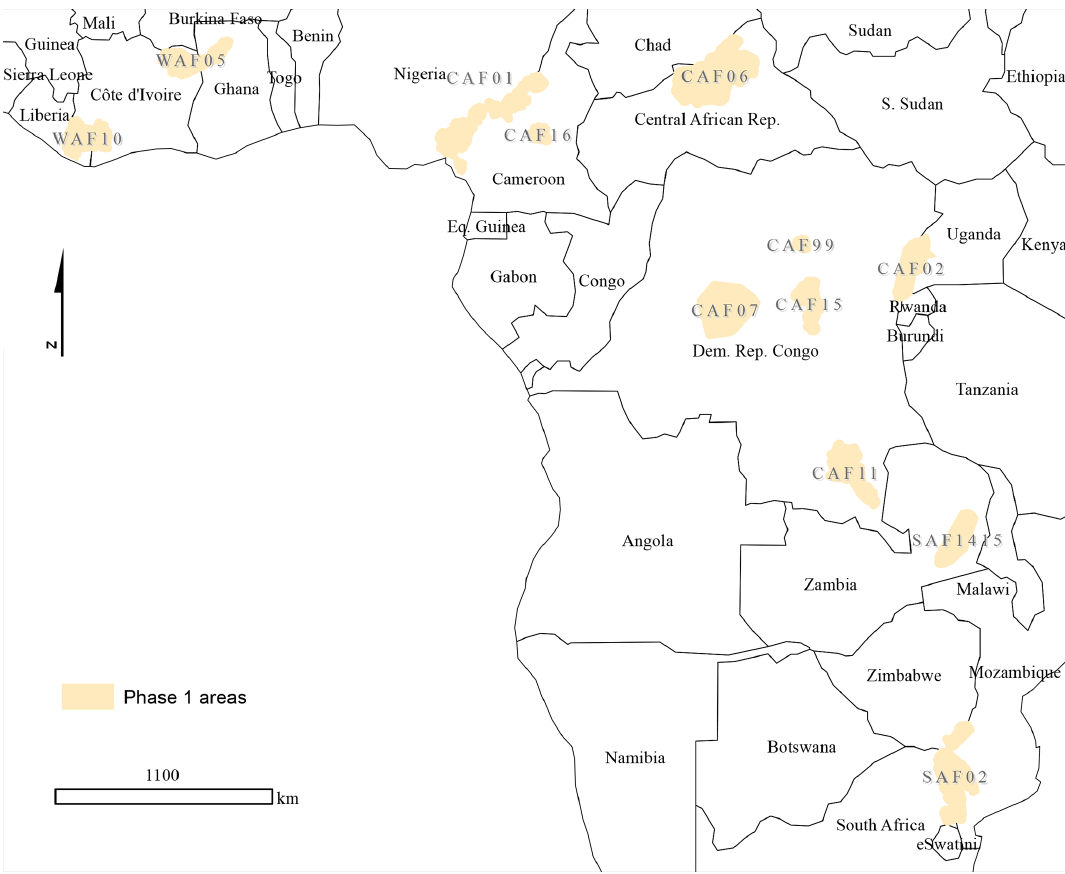
Figure 1. Spatial distribution of the key landscapes for conservation phase 1 areas.